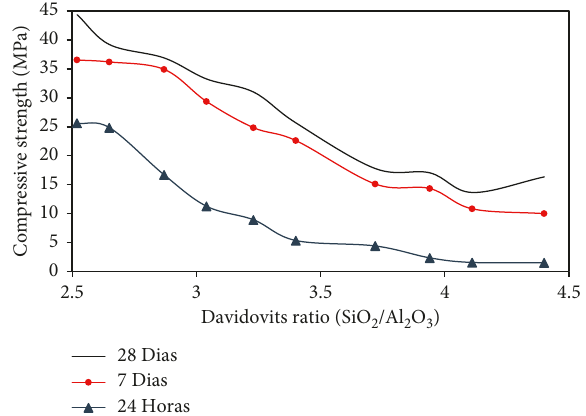
Figure 4: Compressive Strength (MPa) of the geopolymers.